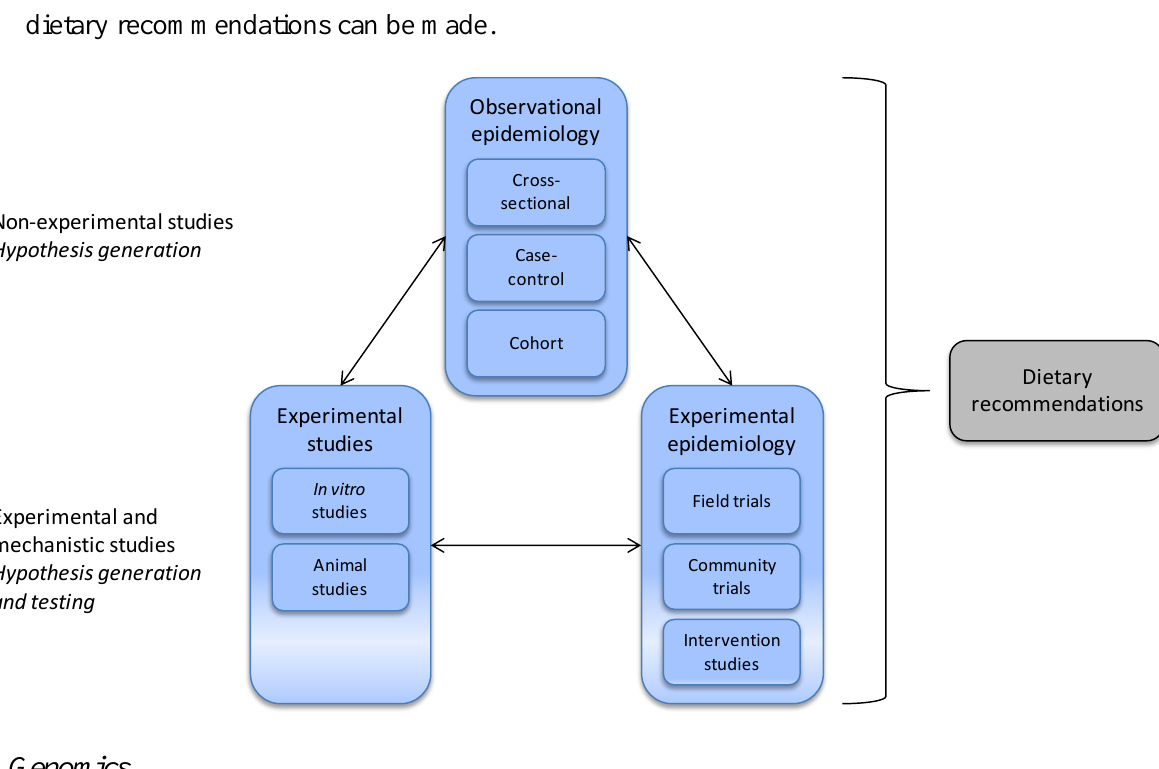
Figure 5. Epidemiological methods related to other studies in nutritional